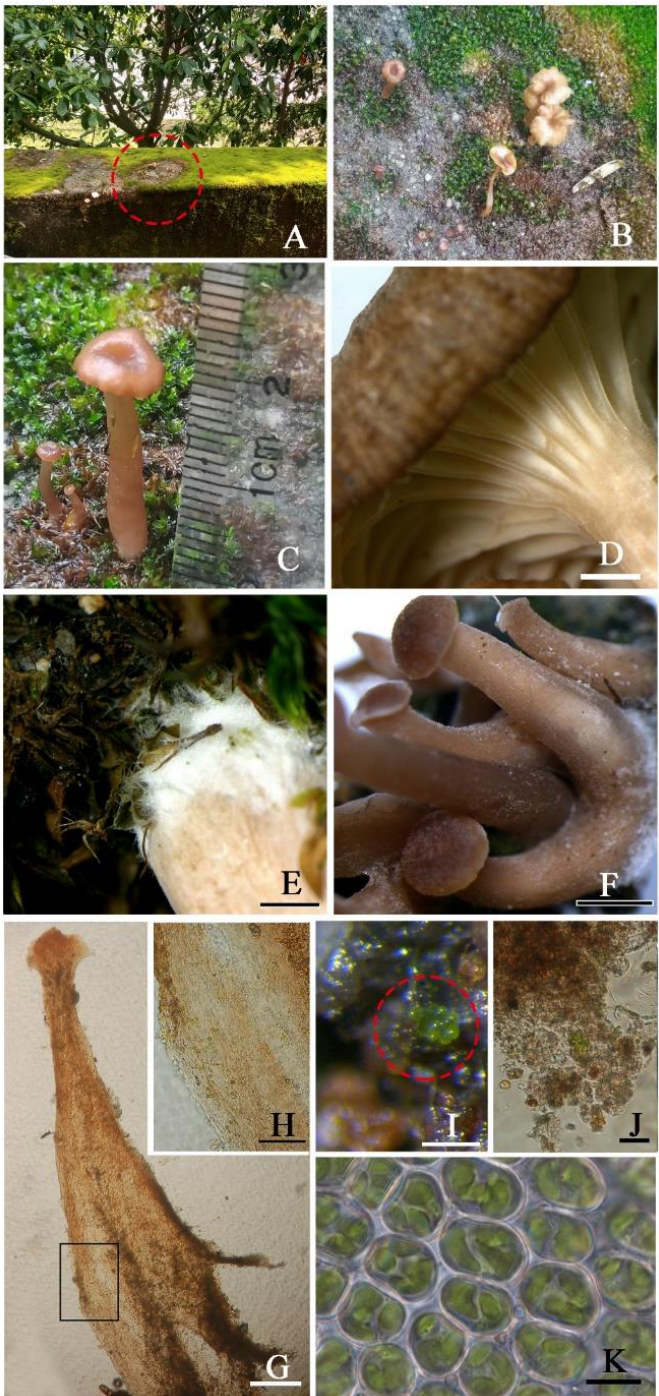
Figure 3. The habitat and habits of Omphalina licheniformis sp. nov (holotype HMAS–L 154705). ( A ) Community balcony in a residential area—the habitat of basidiomata is marked by a red circle. ( B , C ) The basidiomata in situ. ( D ) Lamellae. ( E ) Hair. ( F ) Young basidiomata. ( G ) Microscopic observation of a young basidiomata with green algae cells in the stipe marked by the black box. ( H ) Zoom in on the black box. ( I ) Tiny and very few Botrydina -type vegetative thalli. ( J ) Green algae cells and hyphae in the thallus. ( K ) Leaf cells and chloroplasts inside of the moss Hyophila involute . Bars: D-F = 1 mm, G = 200 µ m, H-I = 100 µ m, J = 20 µ m, K = 10 µ